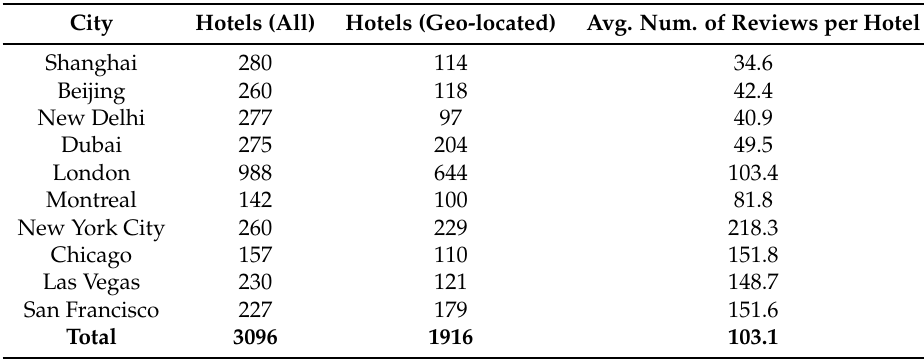
Table 1. Description of OpinRank